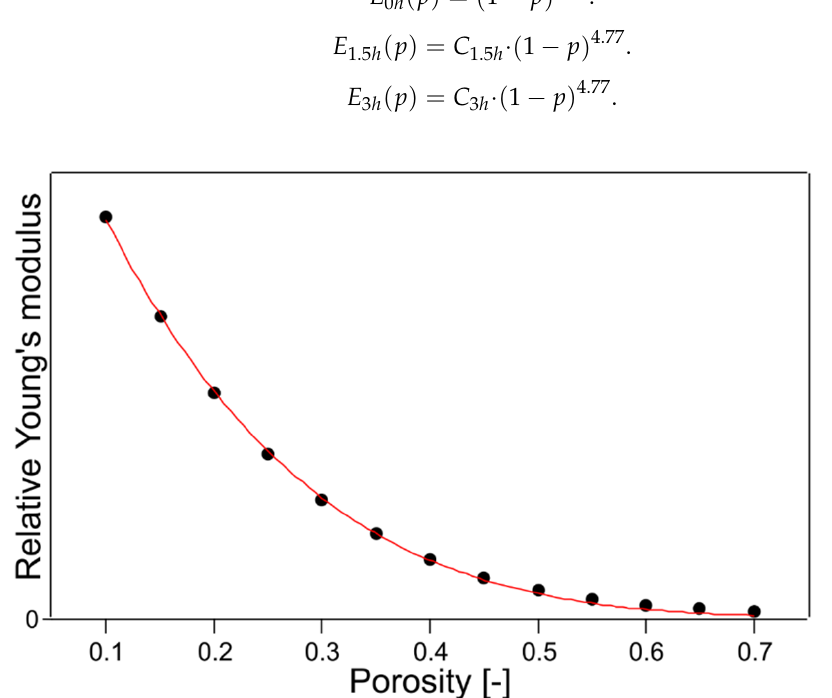
Figure 7. The plot of the quintic function used when designing the multilayer filter [16] and the fitting result with Equation (13).